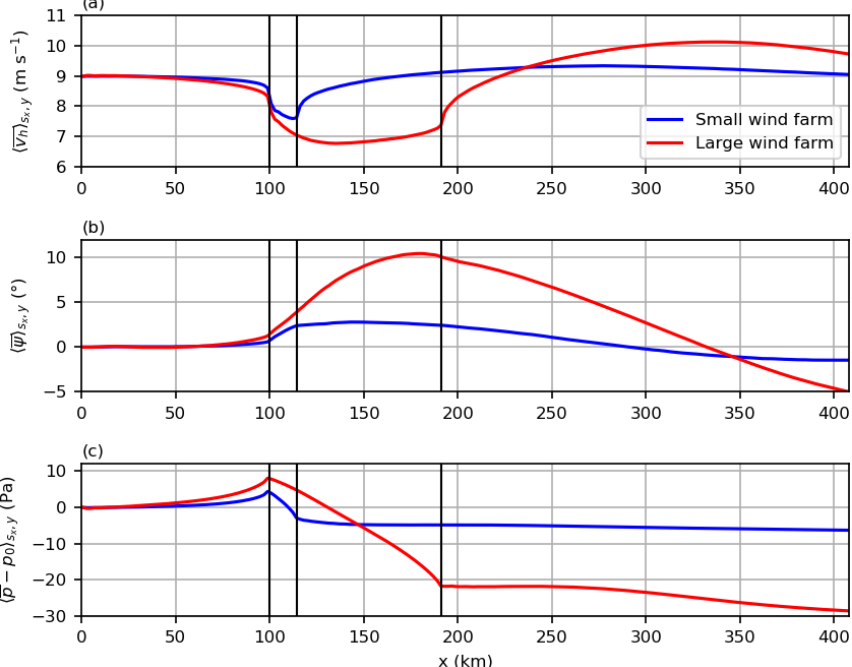
Figure 3. Horizontal wind speed (a) , wind direction (b) and perturbation pressure (c) along x . All quantities are averaged along y and one turbine spacing along x . Vertical black lines indicate LE and TE of the small and large wind